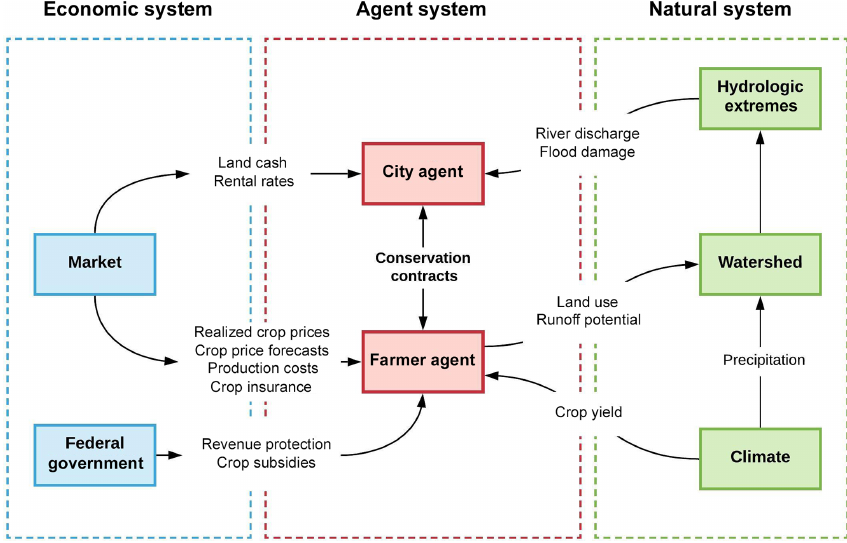
Figure 1. Flow of information within the agent-based